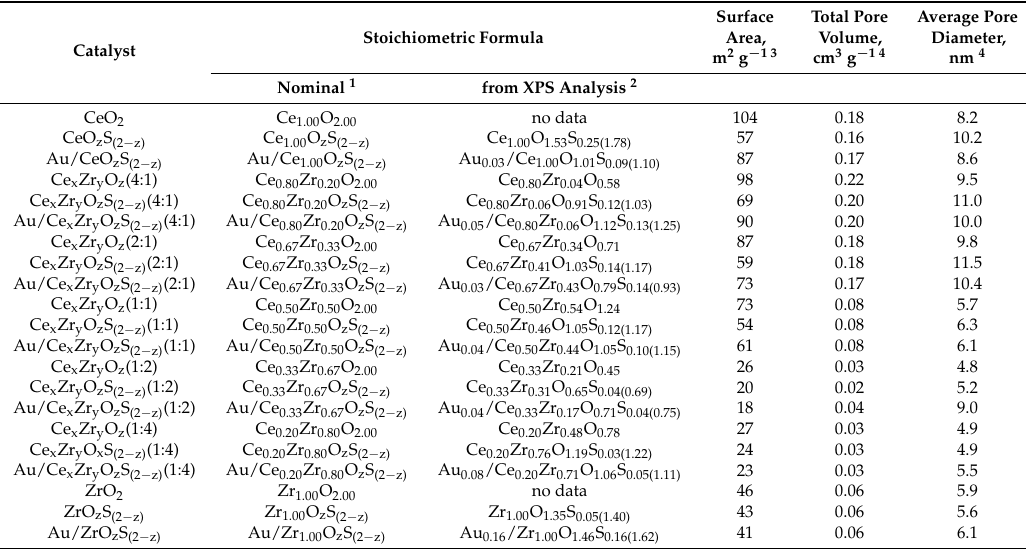
Table 4. Stoichiometric formulas of oxides estimated using X-ray Photoelectron Spectroscopy (XPS) measurements and texture